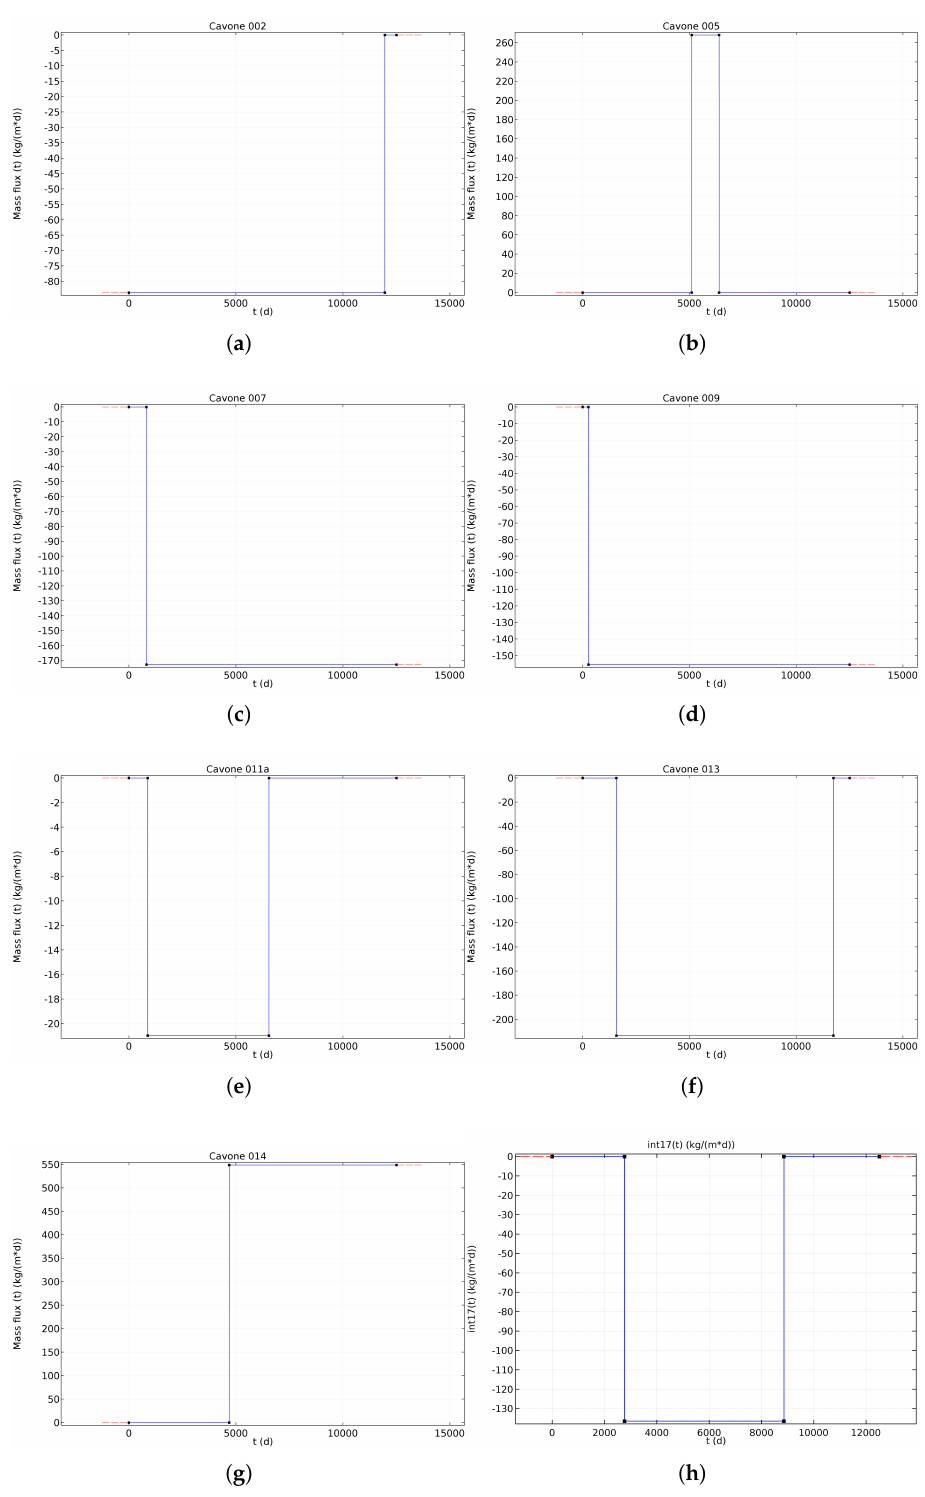
Figure 4. Cavone oilfield modeling: Average mass fluxes of wells C002 ( a ); C005 ( b ); C007 ( c ); C009 ( d ); C011a ( e ); C013 ( f ); C014 ( g ); and C017 ( h